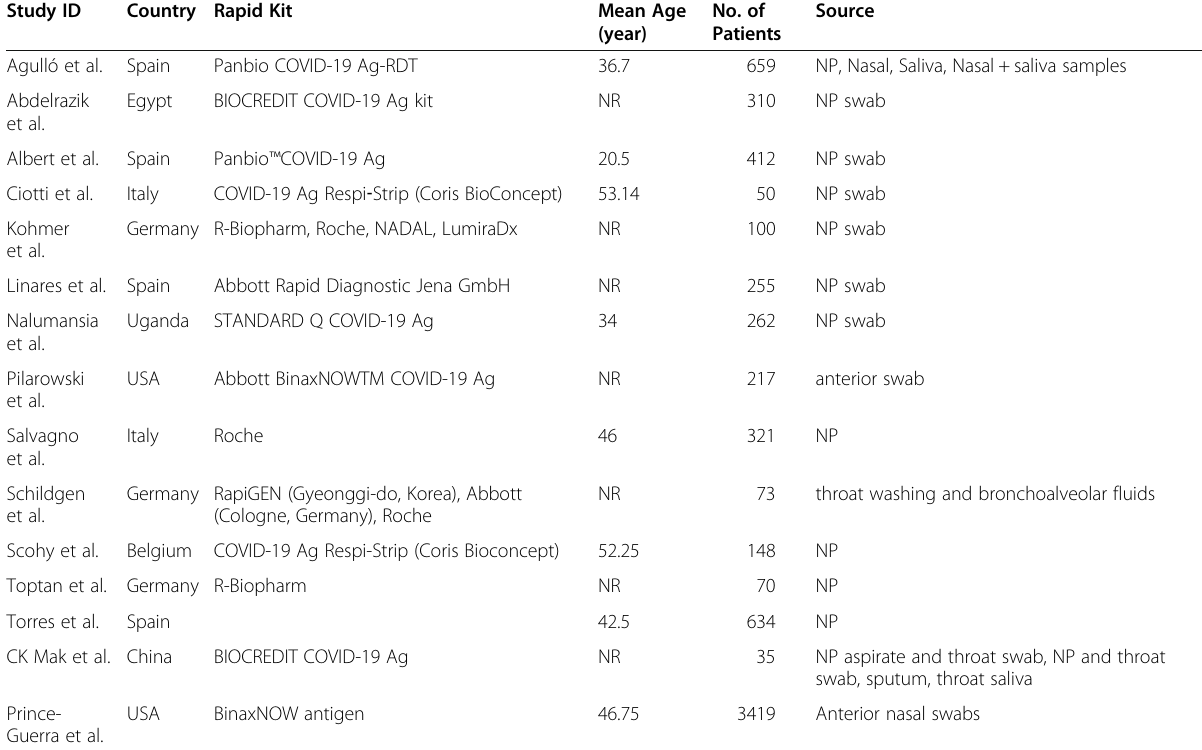
Table 1 Characteristics of included